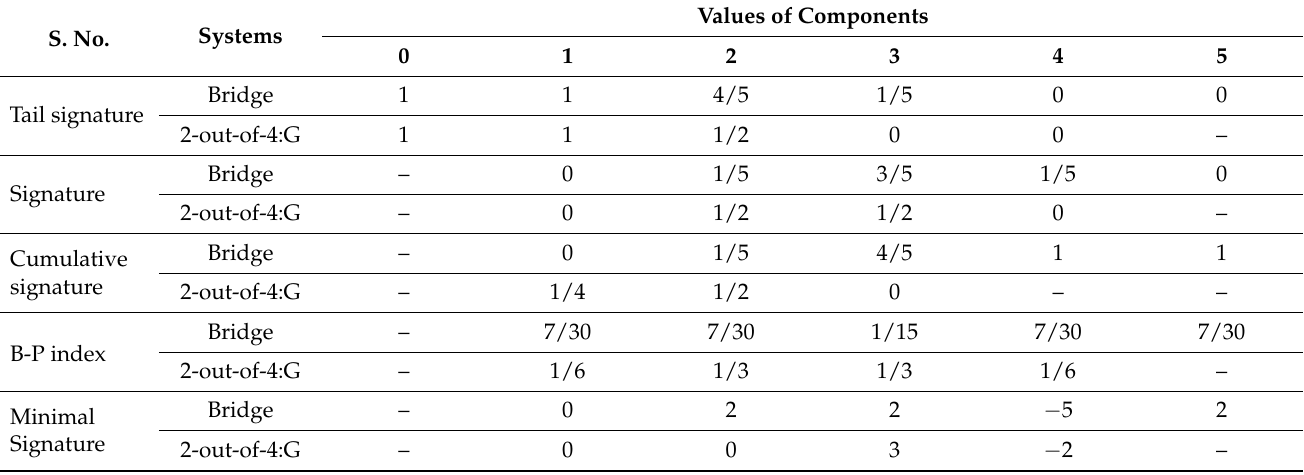
Table 7. Tail Signature, Signature, Cumulative Signature, B - P Index, Minimal Signature of different